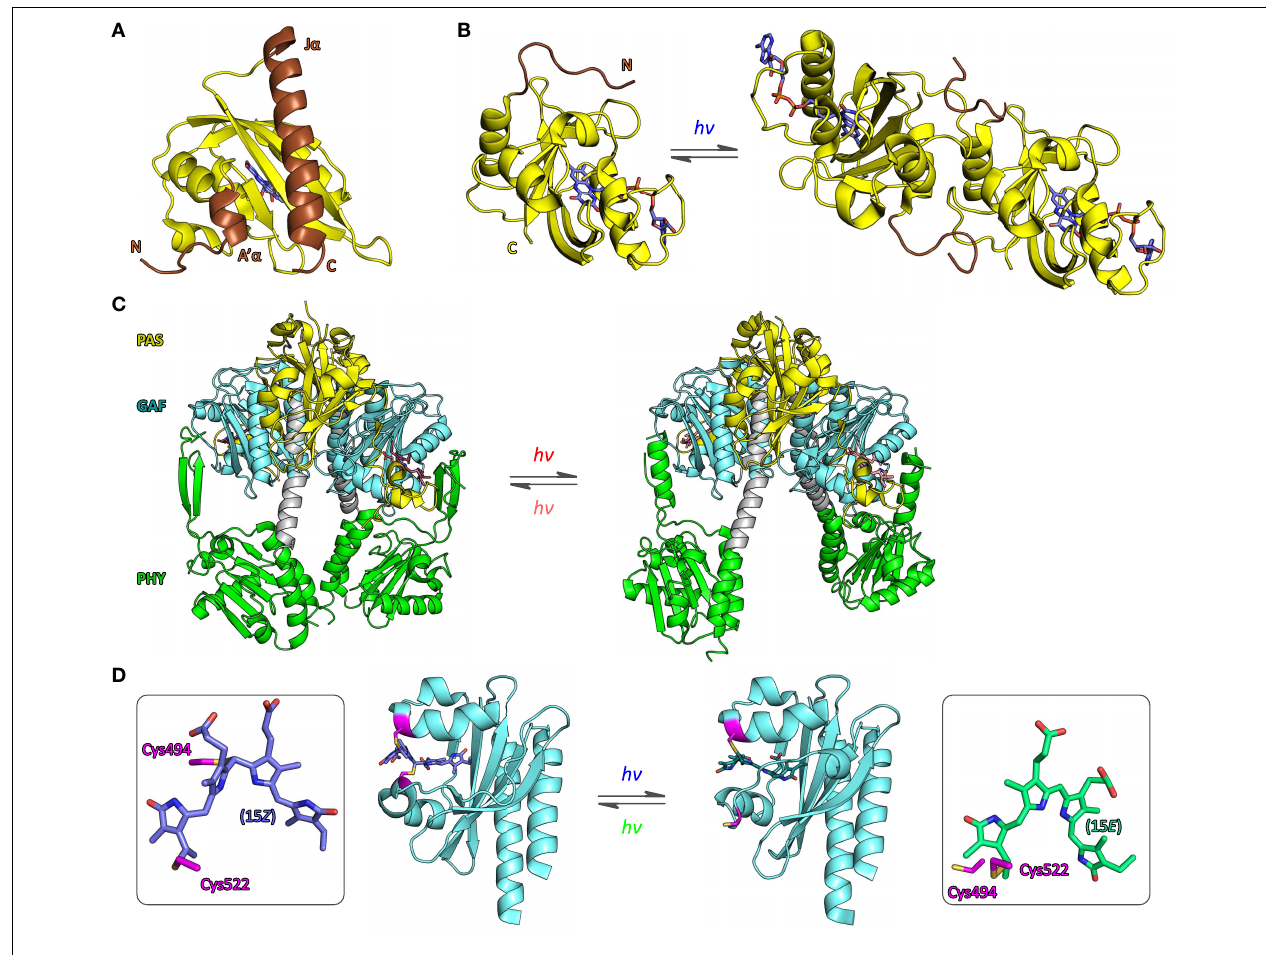
GAF, and PHY domains, in its dark-adapted Pr state (left, 4O0P) and red-light-adapted Pfr state (right, 4O01, Takala et al., 2014) implicate a pivot motion and splaying apart of the PHY domains as the molecular mechanism for light-induced signal transduction. (D) The structure of a cyanobacteriochrome photosensor from the PixJ protein of Thermosynecchococcus elongatus BP-1 has been determined in the dark-adapted, blue-light-absorbing 15 Z state (left, 4FOF, Burgie et al., 2013) and the light-adapted, green-light-absorbing 15 E state (right, 3VV4, Narikawa et al., 2013), where Z and E refer to isomers of the C15 C16 = double bond of the PCB chromophore that is covalently bound to cysteine 522 (see boxes). In the 15 Z state cysteine 494 (magenta) forms a second thioether bridge to the C10 atom of the